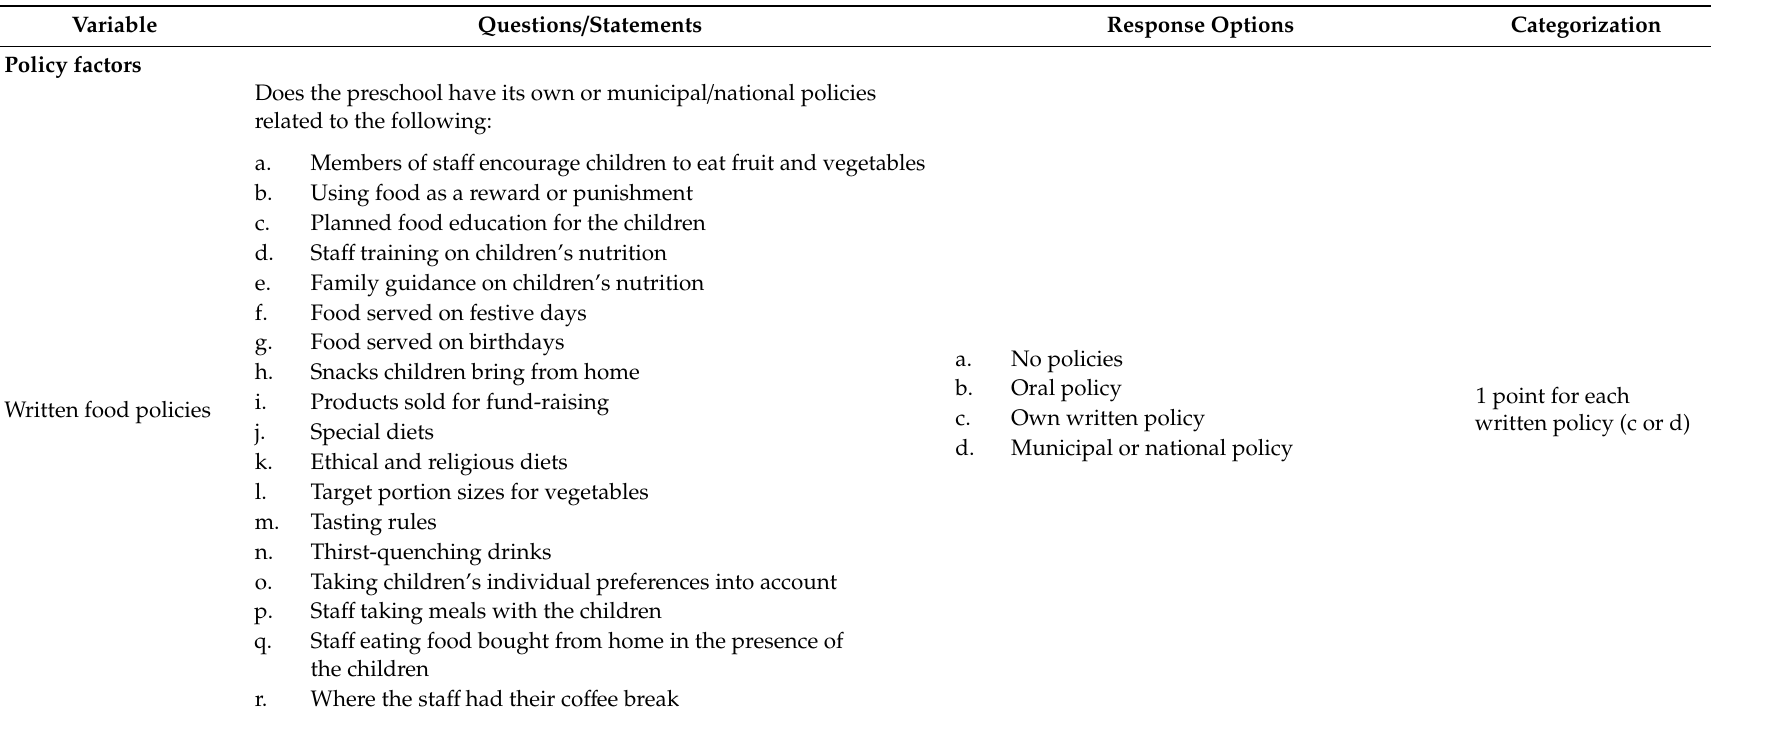
Table 1. Description of the preschool-level variables